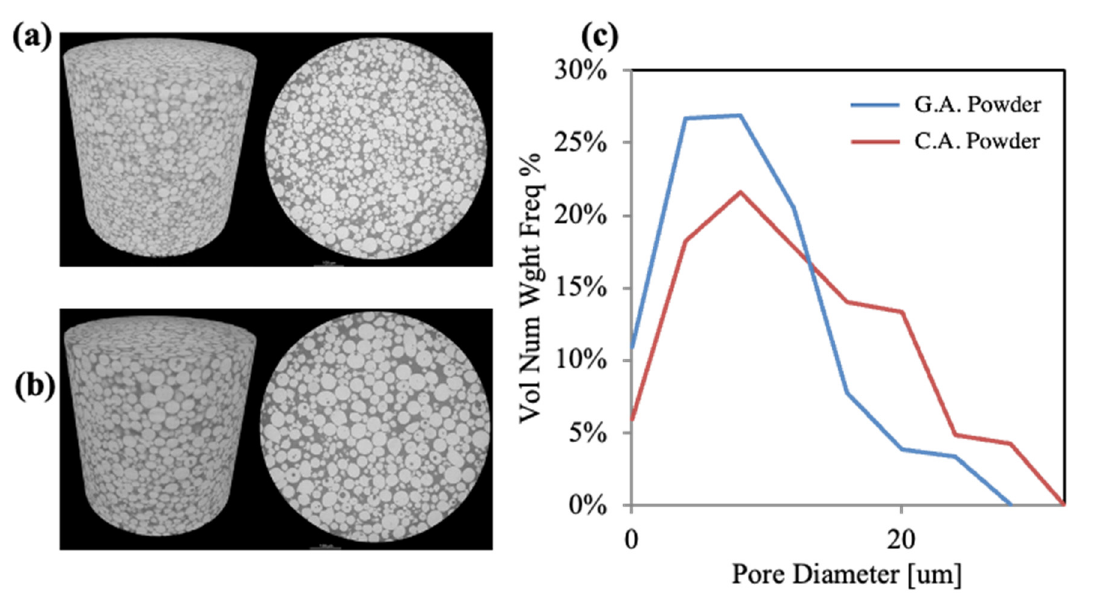
Figure 6. μ CT scan results—snapshot of the scan volume: ( a ) G.A powder and ( b ) C.A powder. ( c ) Pore size distribution.